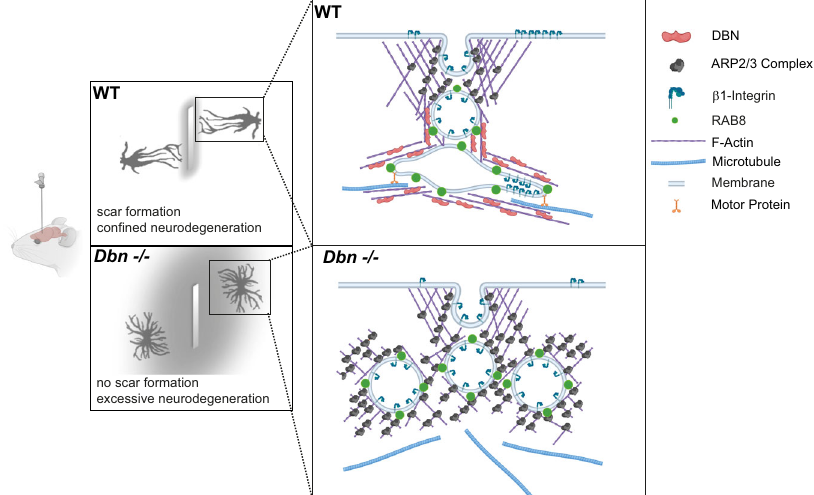
Fig. 7 Astrocytes require DBN to control damage during brain injury. Proposed model of how DBN/Rab8 functions during astrocyte polarization and scarring responses. In response to CNS injury, DBN generates actin scaffolds suitable for tubule-based membrane traf fi cking. DBN-loss results in the accumulation of endocytotic vesicles beneath the plasma membrane and affects the sorting of adhesion receptors essential for interaction with lesion core components. In this way, DBN/Rab8 membrane tubules are fundamental for the polarization and scarring responses of reactive